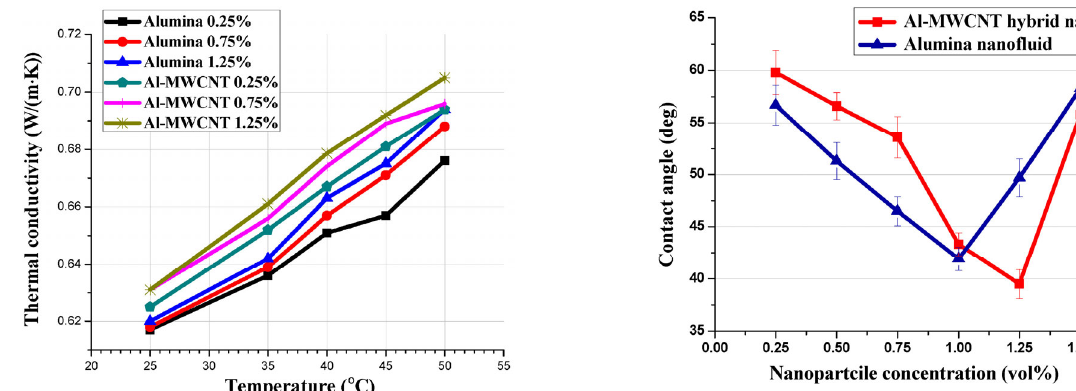
Fig. 5 Thermal conductivity of alumina and Al-MWCNT hybrid nanofluid samples at different temperatures.